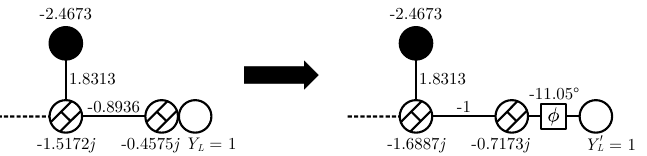
Figure 14. Network with the direct synthesis of the elements resulting in J N + 1 (cid:54) = − 1 ( left ), and once the network transformation is done to achieve J N + 1 = − 1 ( right